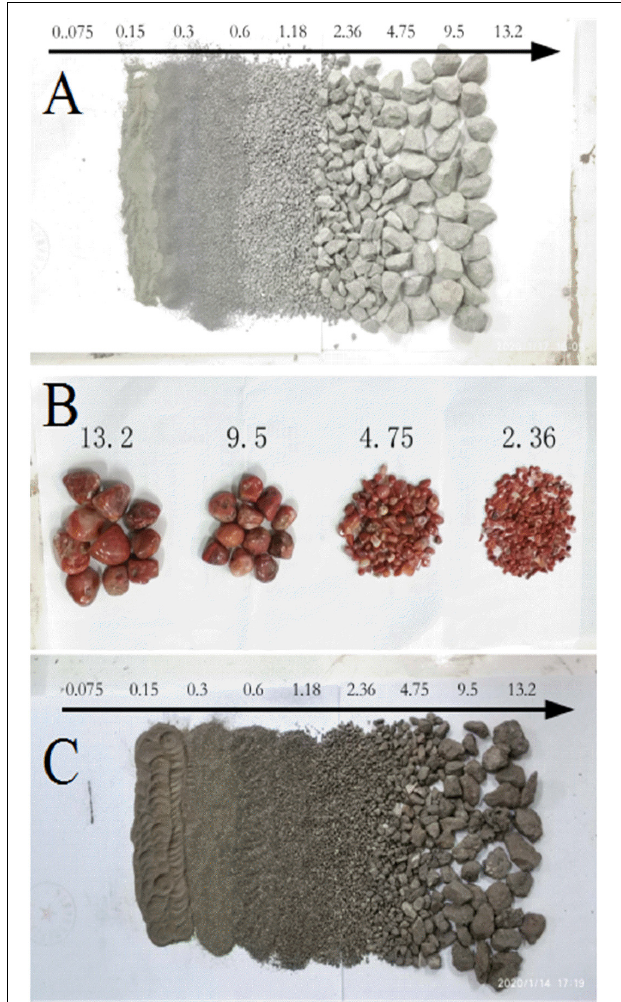
FIGURE 1 | Granite (A) , agate (B) , and old aggregate (C) .